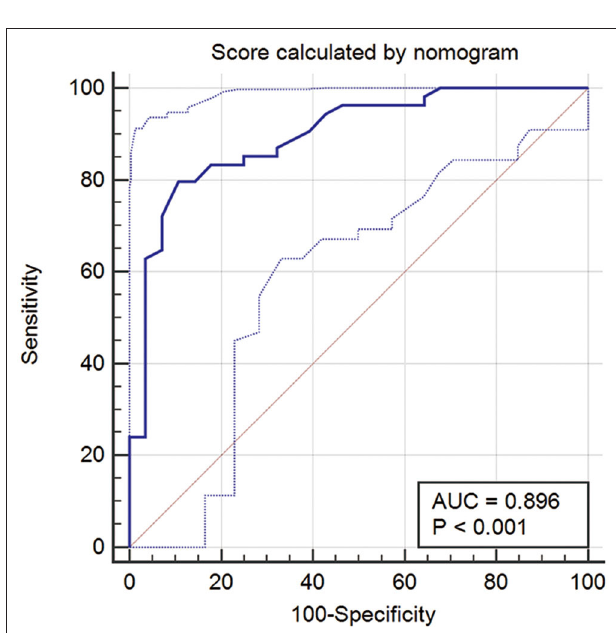
FIGURE 6 | ROC curve when using the score calculated by the nomogram to predict NSCLC. ROC, receiver operator characteristic; NSCLC, non-small cell lung